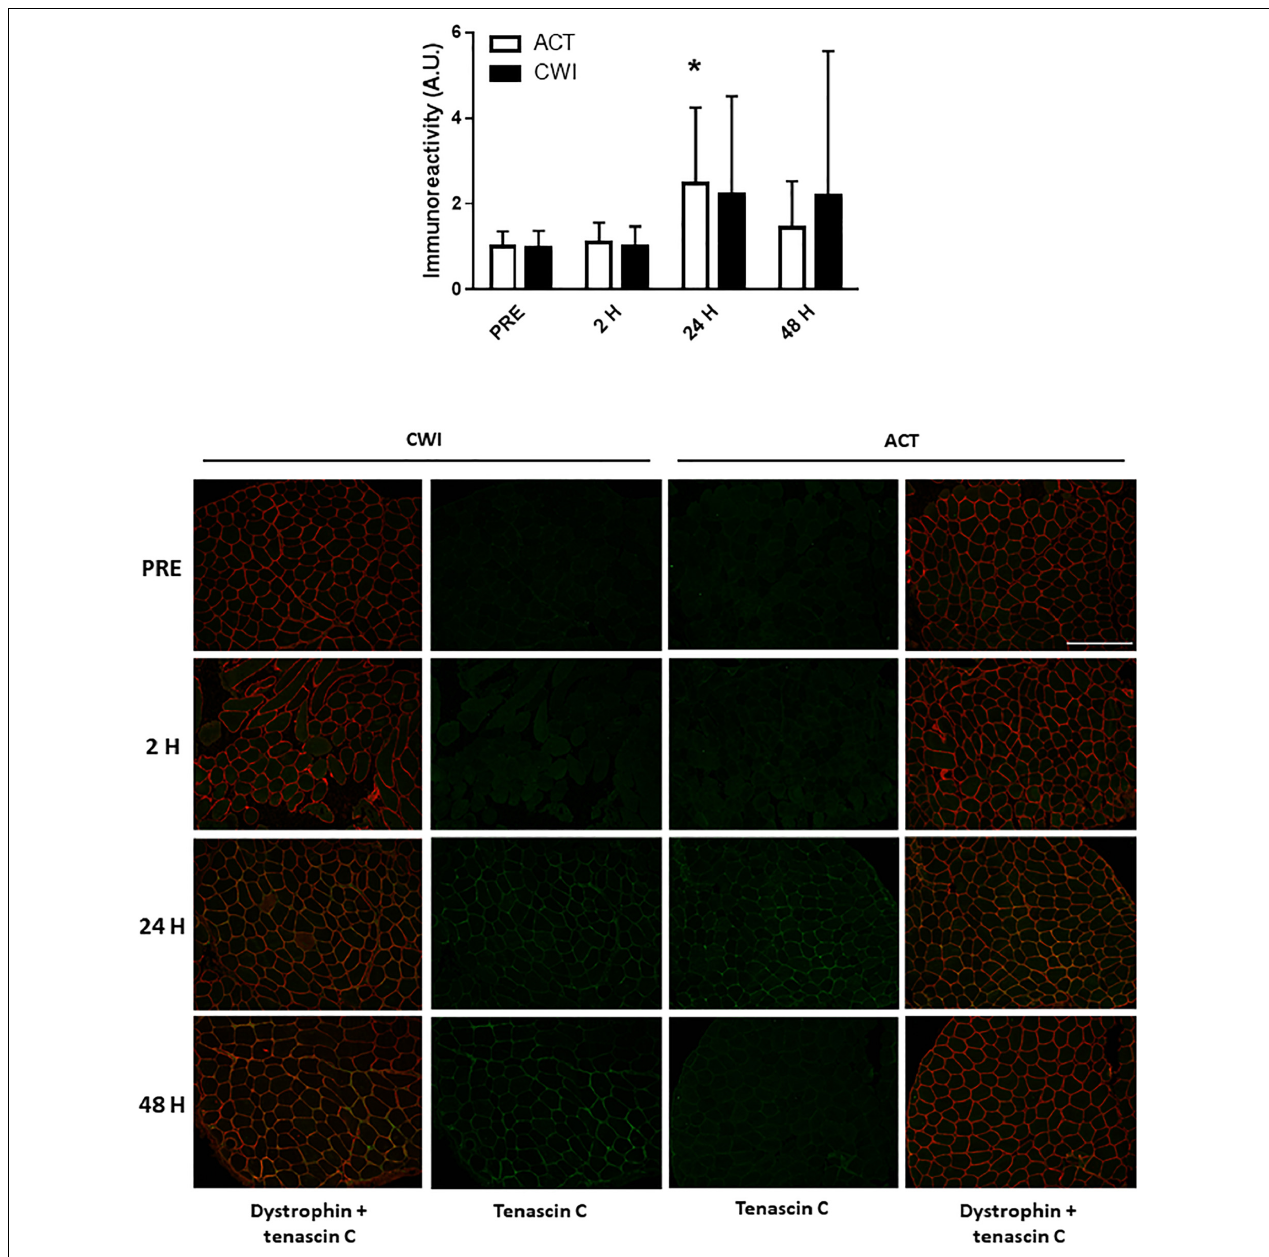
FIGURE 5 | Post-exercise changes in expression tenascin C protein and representative images of tenascin C immunoreactivity in skeletal muscle of one participant. Data are presented as the mean ± SD. * P < 0.05 versus pre-exercise. ACT, active recovery; CWI, cold water immersion. Scale bar represents 200 µ